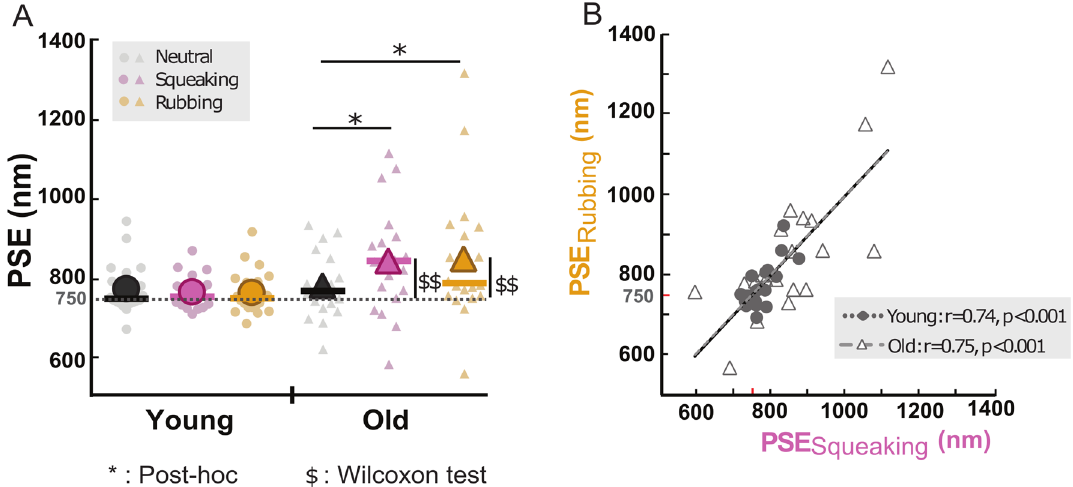
Figure 3. ( A ) Individual and mean point of subjective equality (PSE) values for the younger (dot symbols) and older participants (triangle symbols) in the Squeaking (pink), Rubbing (yellow) and Neutral (black) sound conditions. *p < 0.05, **p < 0.01 for post hoc tests with Holm correction; $ p < 0.05, $$ p < 0.01 for Wilcoxon tests different from zero. ( B ) Correlations between the PSE observed in the Squeaking and in the Rubbing conditions across the two groups (full line) and within each group (Young: black dot line; Old: grey dash line). Symbols are individual percentage of rougher responses compared to the reference texture for young (full dot symbols) and older (empty triangle symbols) participants.